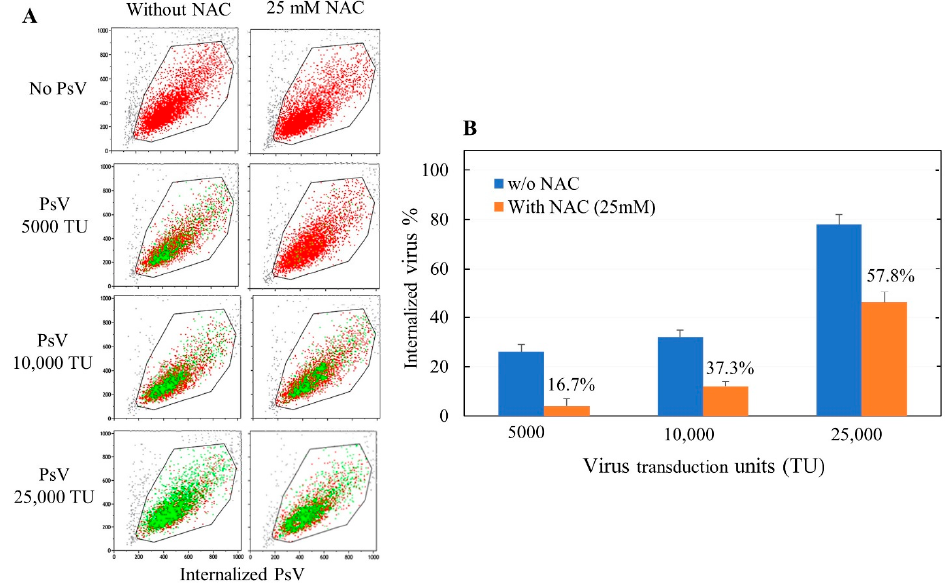
Figure 3. ( A ). Examples of cytofluorimetric analyses of ACE2-HEK293 cells, either unexposed or exposed to delta SARS-CoV-2 pseudovirus (PsV) at the doses of 5000, 10,000, and 25,000 TU/well, either in the absence or in the presence of 25 mM NAC. The red dots indicate pseudovirus-free cells, whereas the green dots indicate cells in which the pseudovirus was internalized. ( B ). Relationship between the virus dose and the proportion of virus internalized either in the absence or in the presence of NAC. The numbers above the NAC columns indicate, at each virus dose, the percent of internalized virus in the presence of NAC as related to the corresponding dose of internalized virus in the absence of